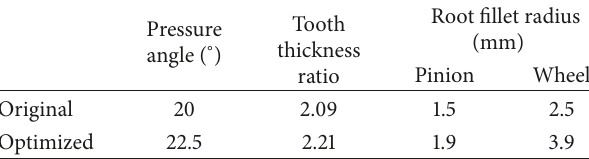
Table 1: Gearing design